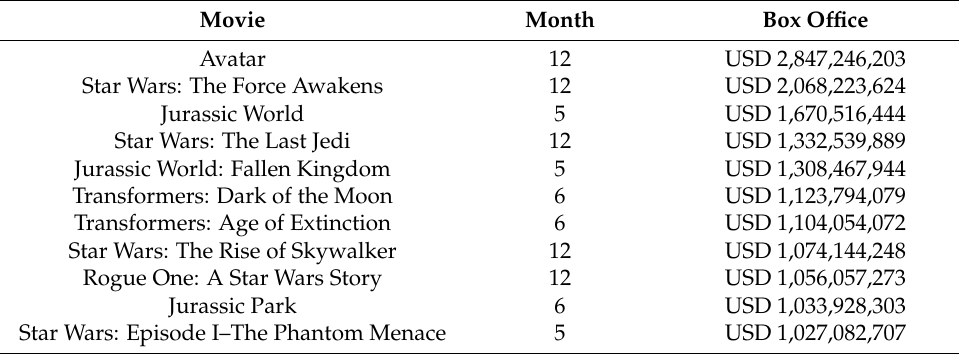
Figure 5. Box office by month. Figure 5. Box o ffi ce by month. Figure 5. Box o ffi ce by month. The highest-grossing science fiction movies of all time are shown in Table 3. Table 3. Highest-Grossing Sci-Fi Movies. Table 3. Highest-Grossing Sci-Fi